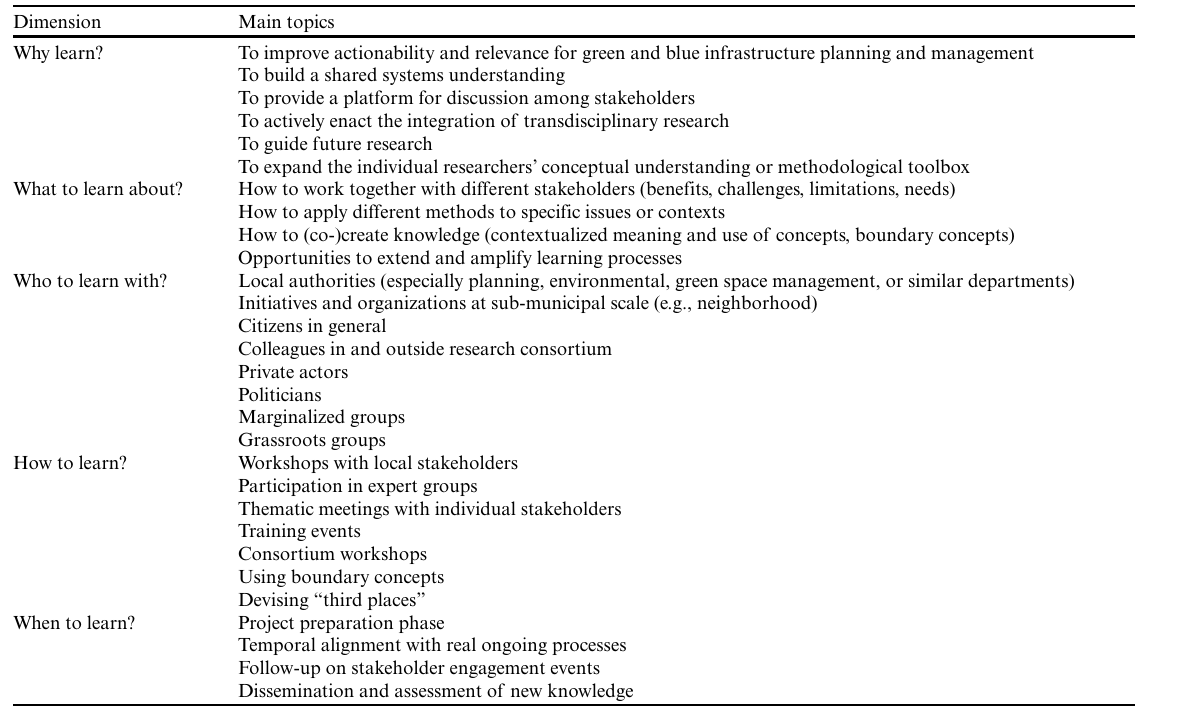
Table 1 . Main topics emerging from the interviews for each dimension of the analytical framework. The contextualization and details given in the main body of text are essential to interpret the topics